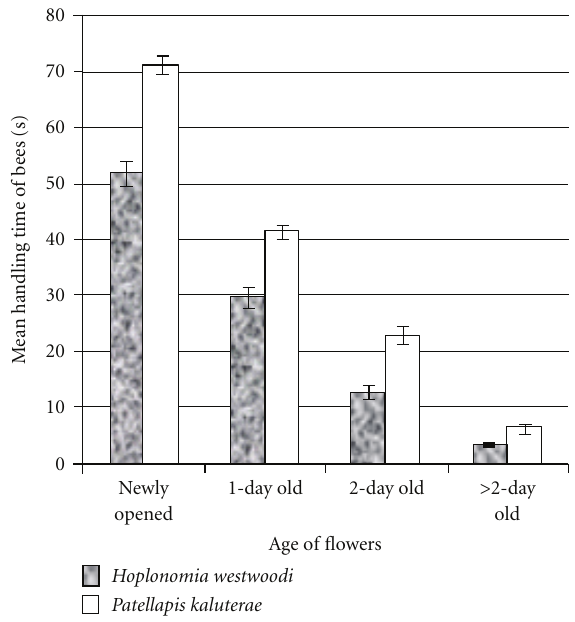
Figure 2: Mean handling time of Hoplonomia westwoodi and Patellapis kaluterae in Solanum violaceum flowers of di ff er- ent age in the site at Kegalle. (Mean temperature ( ◦ C), rain fall (mm), and relative humidity during the time of